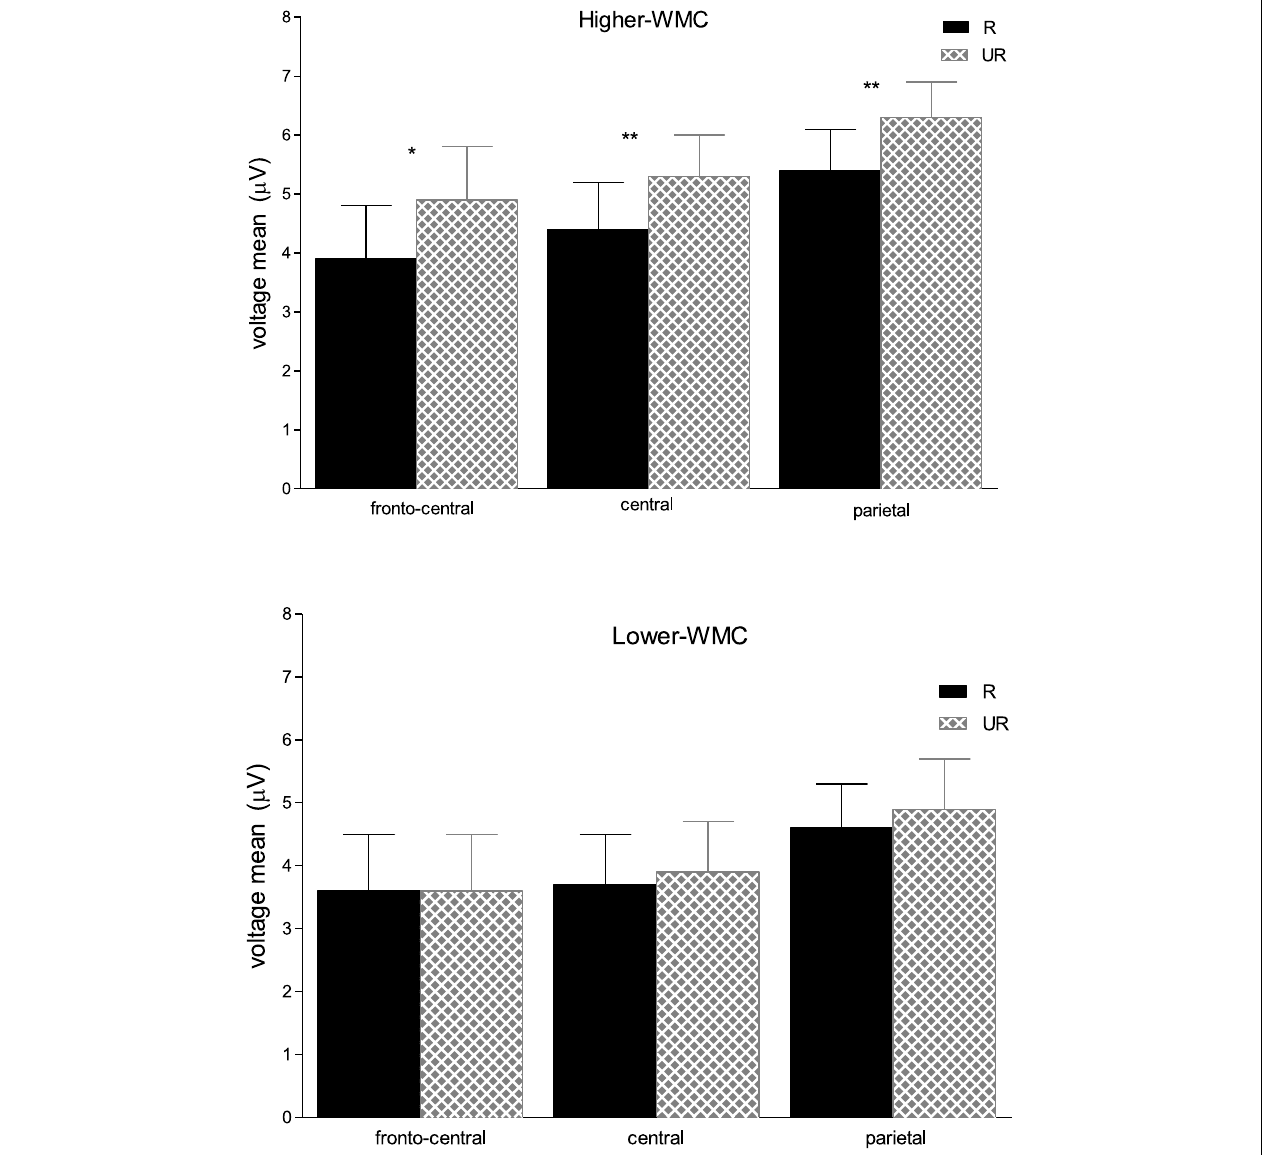
FIGURE 5 | Mean ERP voltages ( µ V) in the 490–590 ms time interval at fronto-central (FC1/FC2/FCz), central (C3/C4/Cz), and parietal (P3/P4/Pz) electrode sites, as a function of Relatedness (Unrelated vs. Related) in the delayed masking trials, and Capacity Group (High-WMC vs. Low-WMC); error bars indicate the standard error of means, asterisks denote significant differences of Unrelated vs. Related conditions; ** p < 0.01; * p <